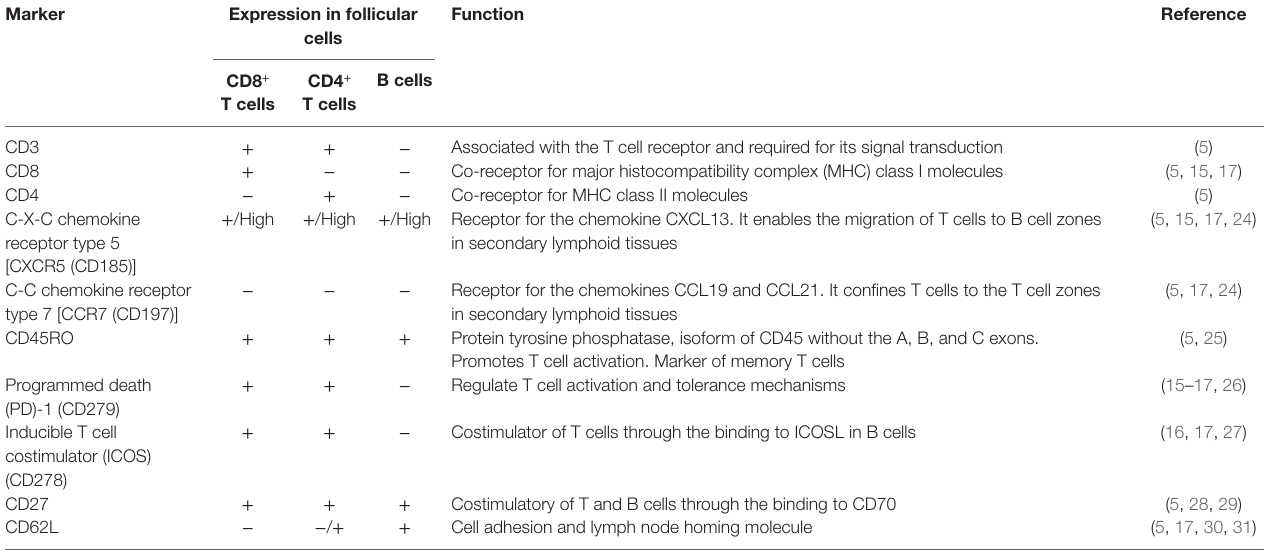
TABLe 1 | Phenotypic markers of follicular cells and their function.